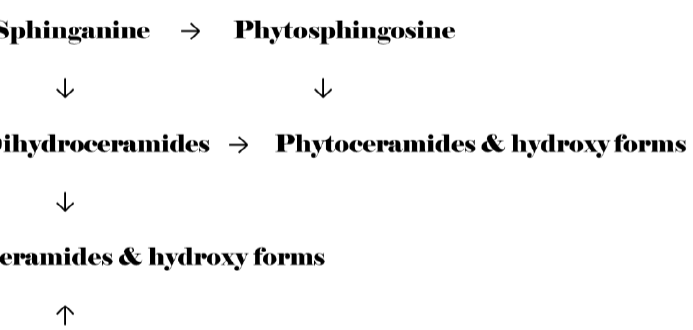
Figure 6. Schematic of sphingolipid metabolism. Hydroxylation of free sphingolipid bases is cata- lyzed by monooxygenases (SUR2) and of sphingolipid bases in dihydroceramides via hydroxylases (DES2). The introduction of hydroxylation at position 2 of the fatty acid substituents of ceramides occurs via de novo synthesis with a hydroxy fatty acid (CERS, ceramide synthase) and via lipid modification by ceramide fatty acyl 2-hydroxylase (FA2H; phytoceramide → 2-hydroxy-phytoceramide).